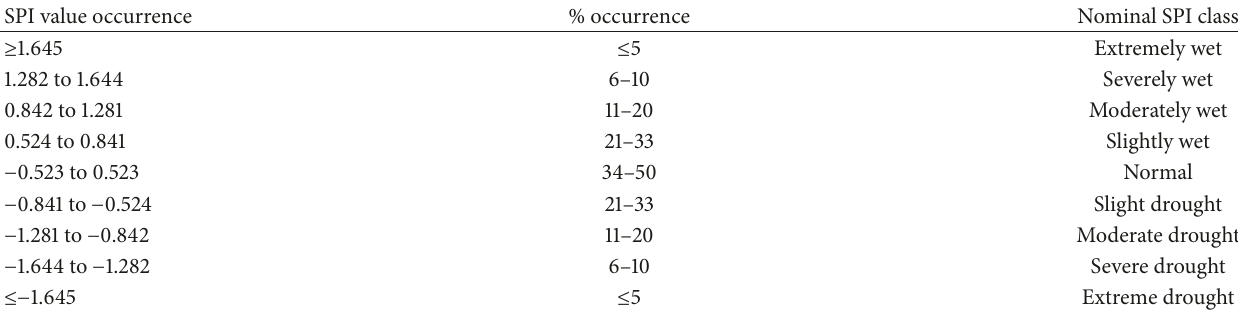
Table 1: Categorization of dryness/wetness.